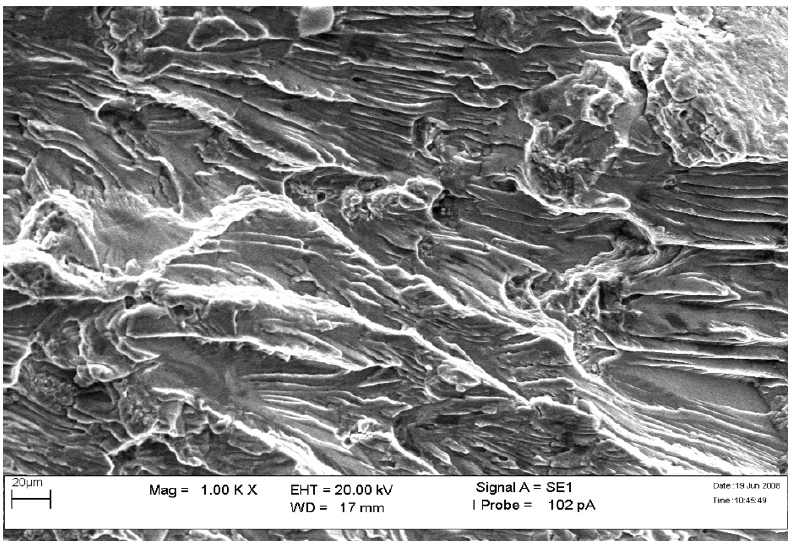
Figure 11. SEM image shows the fatigue striation (1000×).